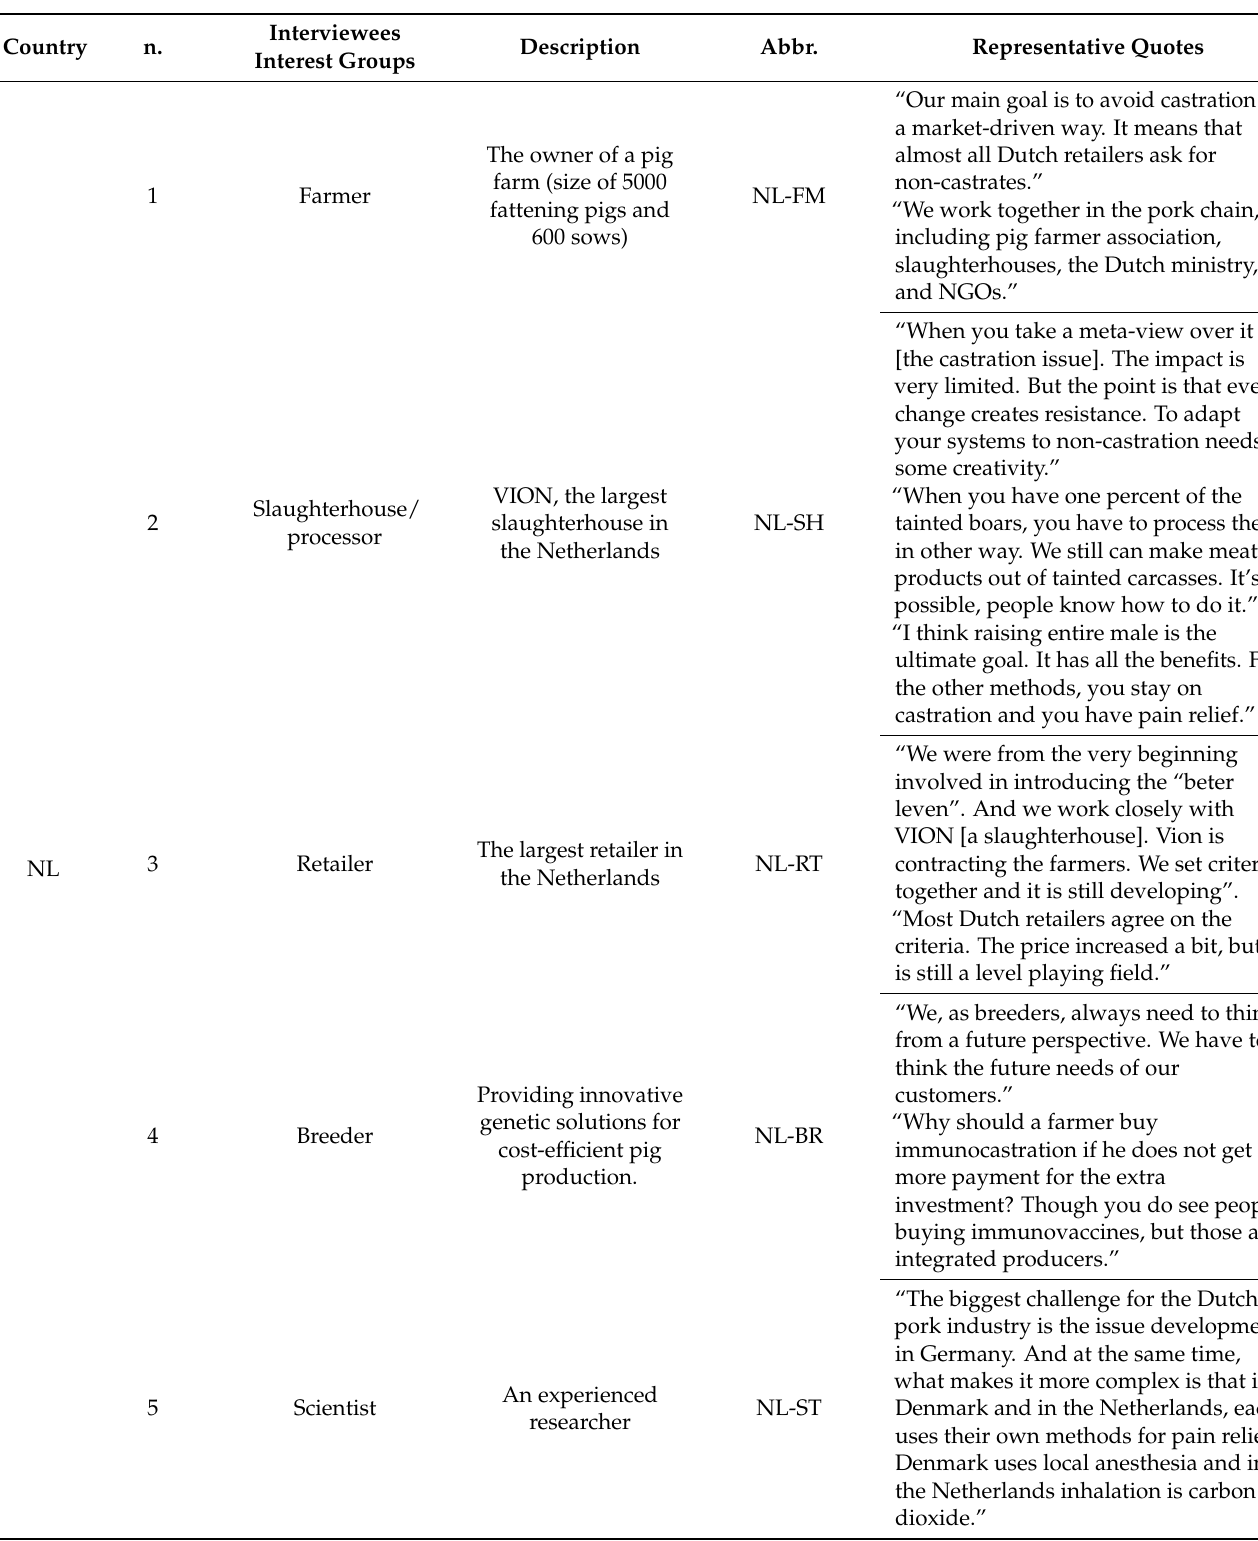
Table 4. Representative quotes from